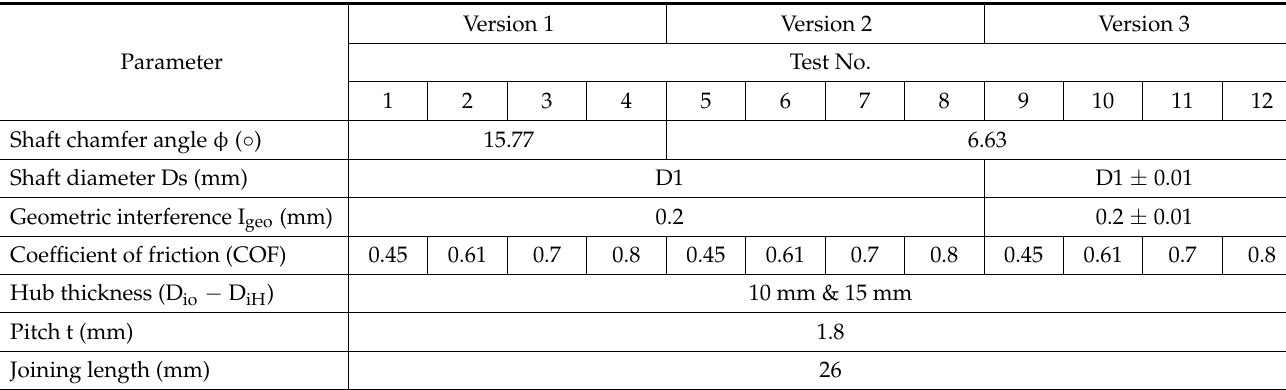
Table 4. Parameters of the design for different tests.